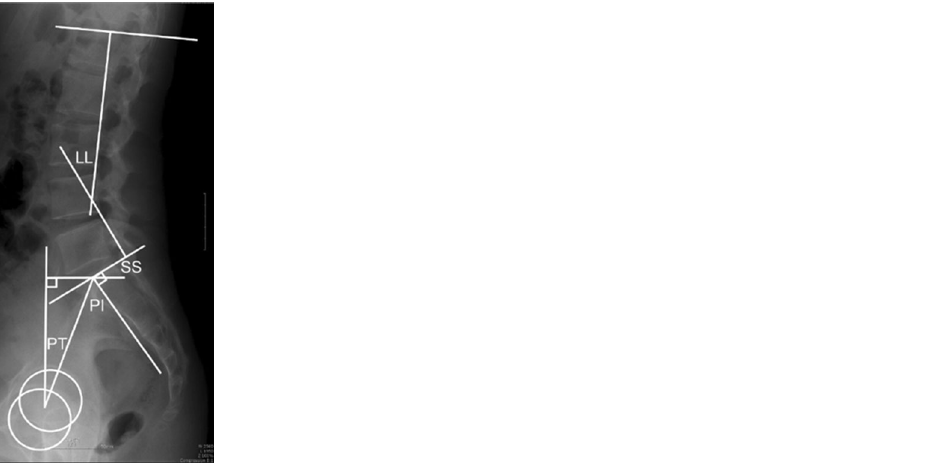
Figure 3. Schema of the measuring methods for each spino-pelvic parameter on a standing radiograph of the whole spine and pelvis. LL, lumbar lordosis; SS, sacral slope; PI, pelvic incidence; PT, pelvic